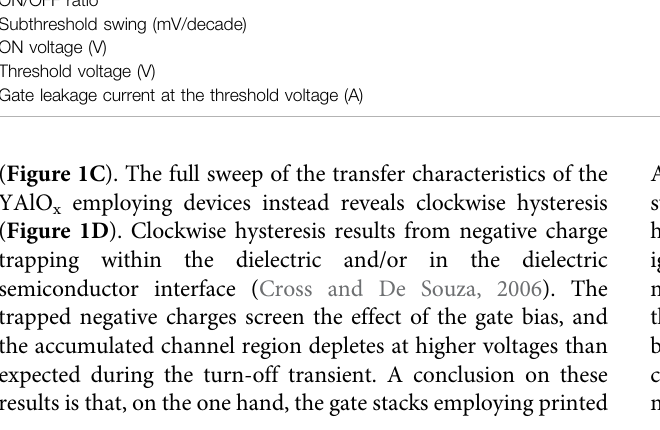
TABLE 1 | Device parameters of the TFTs with a single type of dielectric layers. Extracted